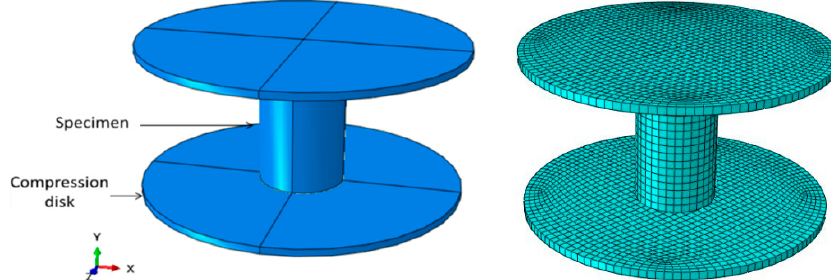
Figure 1. Geometry ( left ) and mesh configuration ( right ) of FE model representing the Bis-GMA polymer under compression loading condition.